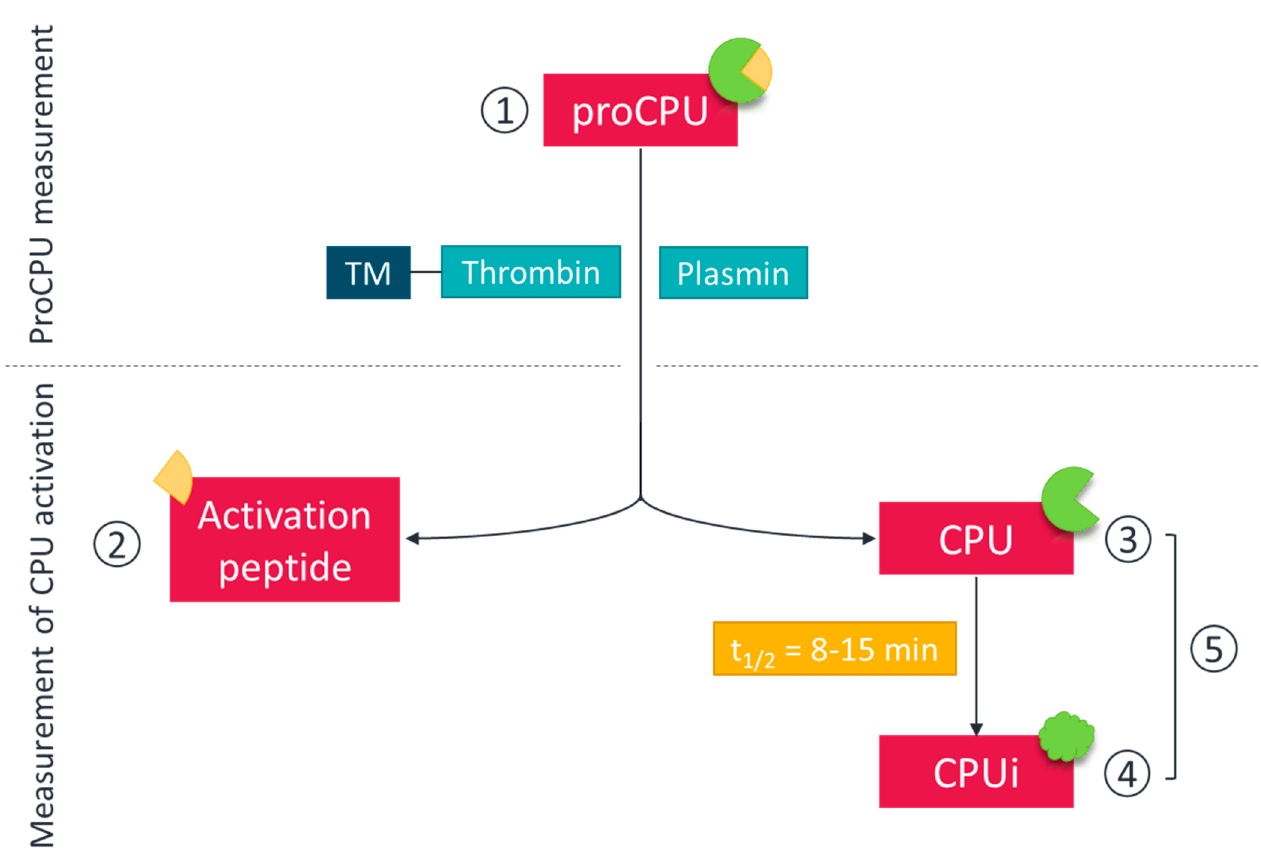
Figure 1. Measurement of different forms of the CPB2 gene product. The zymogen procarboxypeptidase U (proCPU) ( 1 ) can be measured with antigen- or activity-based assays. Carboxypeptidase U (CPU) activation can also be determined. Upon activation with thrombin, the thrombin-thrombomodulin (TM) complex, or plasmin, the activation peptide (AP; 2 ) is released and can be measured with an antigen-based assay. The active enzyme CPU can be directly measured by enzymatic assays ( 3 ). The active enzyme CPU is thermally inactivated into CPUi ( 4 ) which can be measured with antigen-based assays that detect both CPU and CPUi simultaneously ( 5 ).